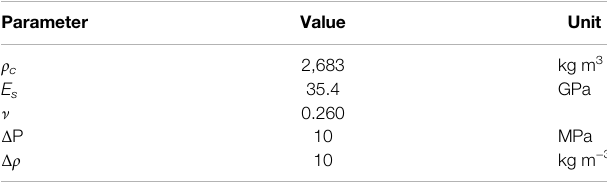
TABLE 3 | Median values of mechanical properties(for 0 > z > − 33 km reported in Table 2 ) and source parameter changes assigned to generic models.